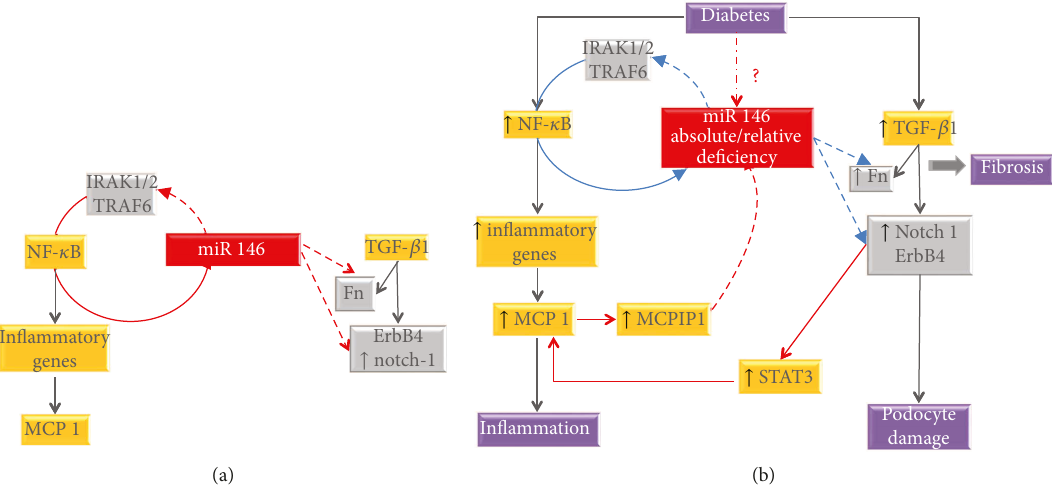
Figure 1: Role of miR-146a in diabetic microvascular complications. (a) In normoglycemic conditions, miR-146 is induced by NF- κ B, and it inhibits NF- κ B by suppressing its target genes interleukin-1 receptor-associated kinase 1/2 (IRAK1/2) and TNF receptor-associated factor 6 (TRAF6). Moreover, miR-146 represses expression of fi bronectin (Fn) in retinal cells and ErbB4/Notch1 in podocytes. (b) In the presence of diabetes, there is an absolute/relative miR-146 de fi ciency leading to insu ffi cient inhibition (light blue lines) of IRAK1/2/TRAF6 (enhancing in fl ammation), Fn expression (favoring fi brosis), and TGF- β 1/ErbB4/Notch1 signaling (leading to podocyte damage). Enhanced signaling through the TGF- β 1-ErbB4 pathway increases autocrine synthesis of MCP-1, further reducing miR-146a levels via MCPIP1 in a feed- forward loop. Grey boxes: miR-146 target genes; dotted lines: inhibition; continuous line: